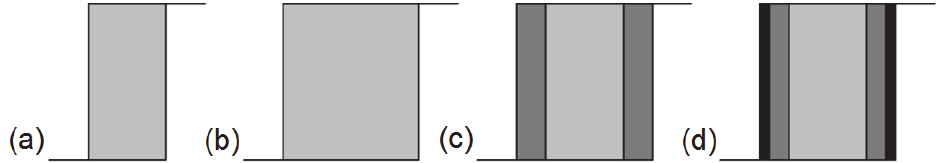
Figure 3. Possible approaches to addressing the change in hysteresis shape at increased excitation